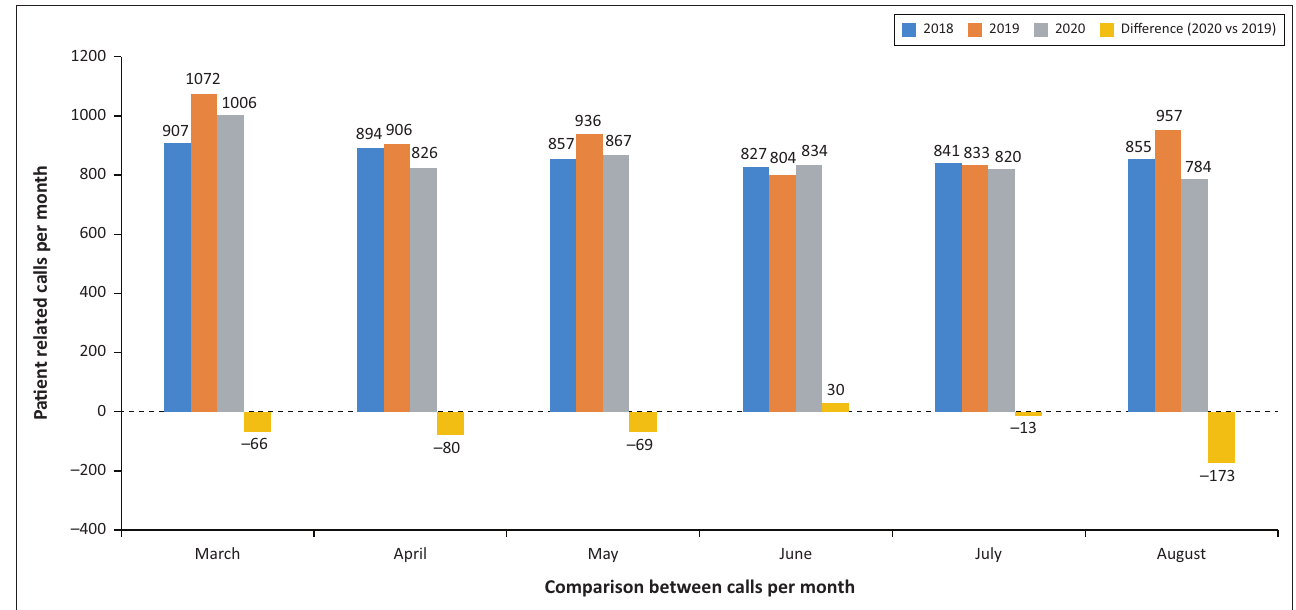
FIGURE 1: Number of calls received by the Poisons Information Helpline of the Western Cape during the first six months of the COVID-19 pandemic and similar periods during the two preceding